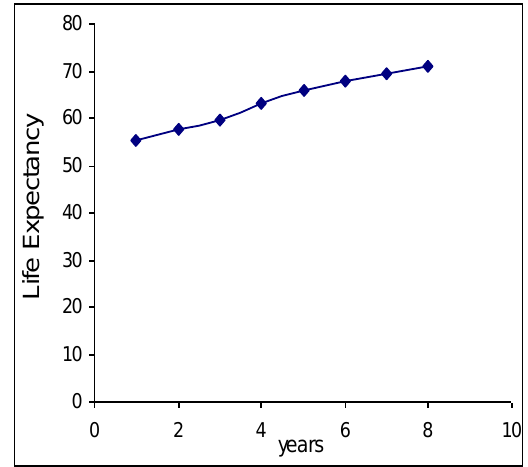
Fig. 3. Life expectancy in Iran 1970-2010.